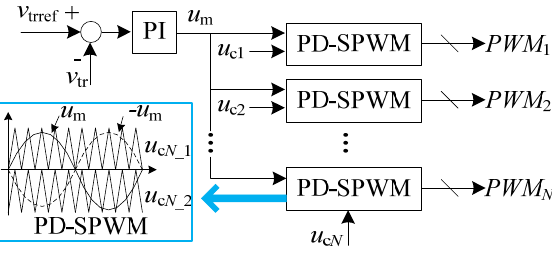
Figure 5. Block control diagram of the single-phase PWM (pulse width modulation) cascade inverter.